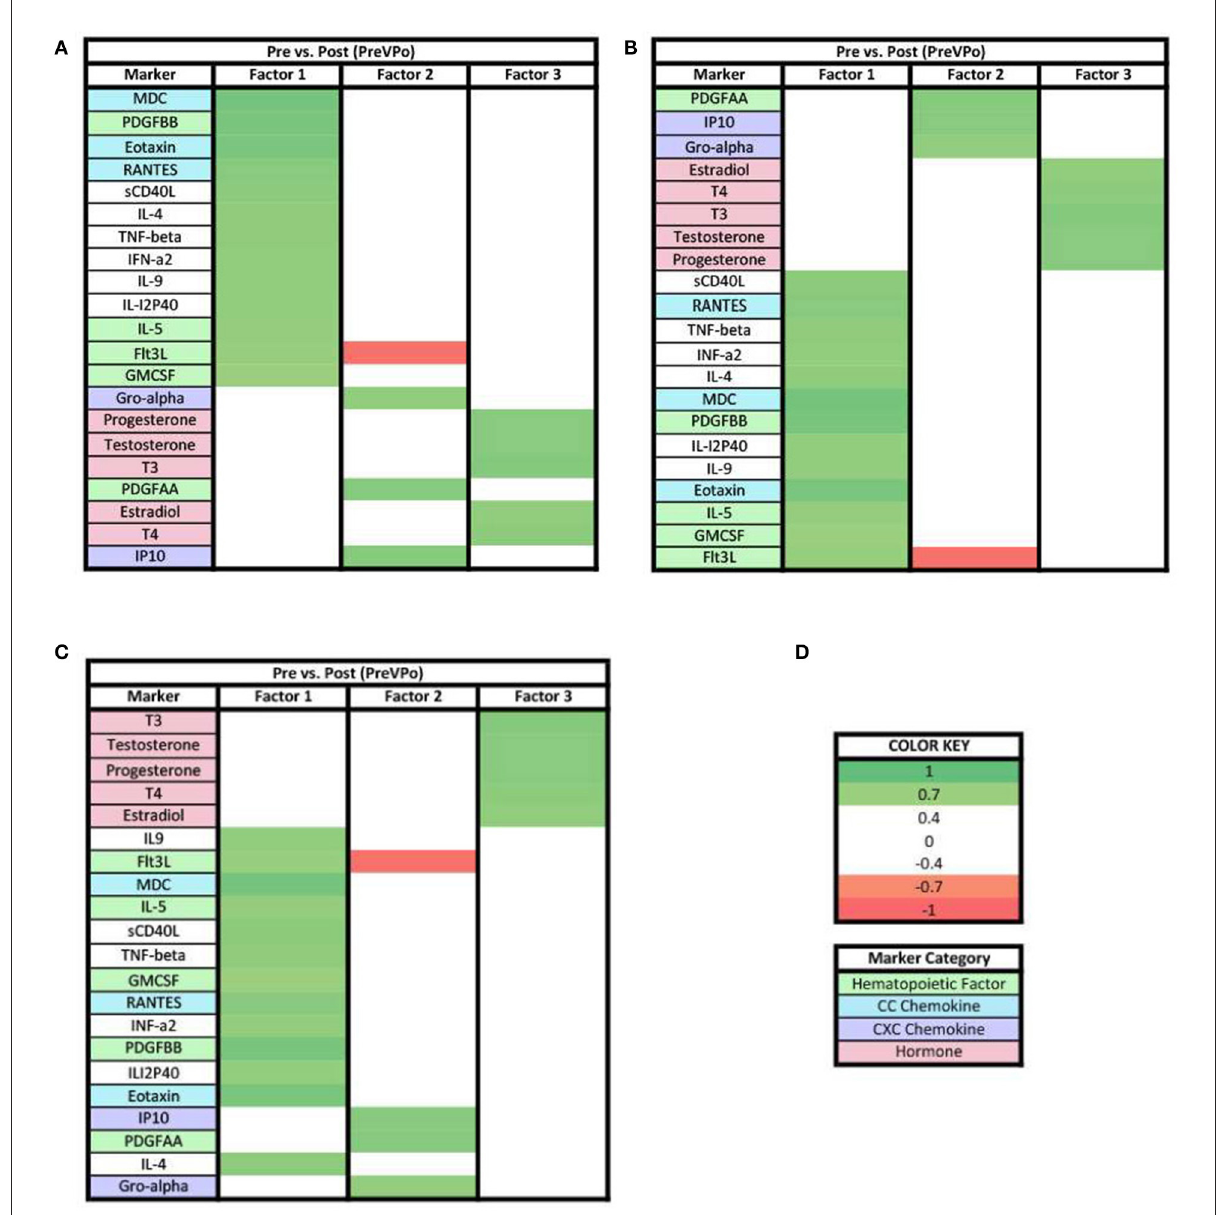
FIGURE5 Heat maps of the pre-stress vs. post-stress (PreVPo) analysis of loadings ≥ 0.7. (A) Biomarkers sorted from highest to lowest loading in PreVPo factor 1. (B) Biomarkers sorted from highest to lowest loading in PreVPo factor 2. (C) Biomarkers sorted from highest to lowest loading in PreVPo factor 3. (D) Color key for PreVPo loadings ≥ 0.7, sorted top to bottom from most positive to most